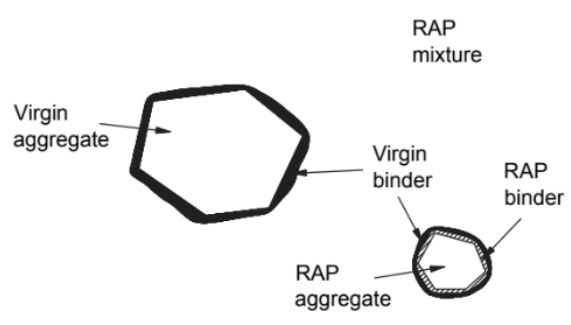
Figure 2. Composite-layered system in recycled asphalt pavement (RAP) Virgin [20].